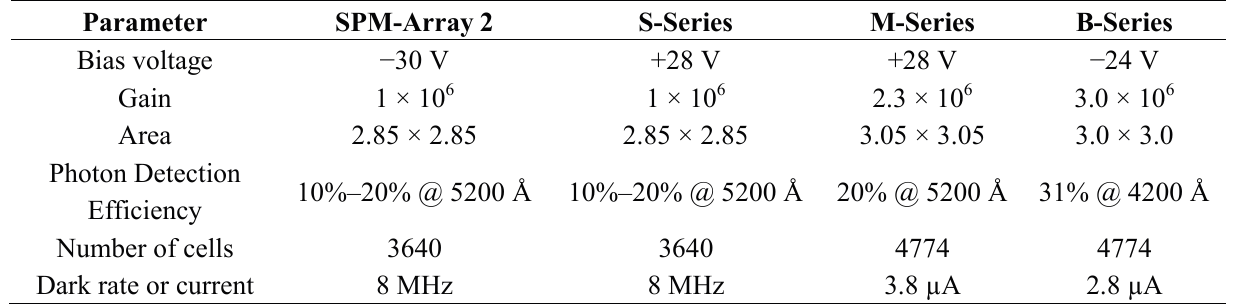
Table 2. Specifications of SensL 4 × 4 SiPM arrays used in this